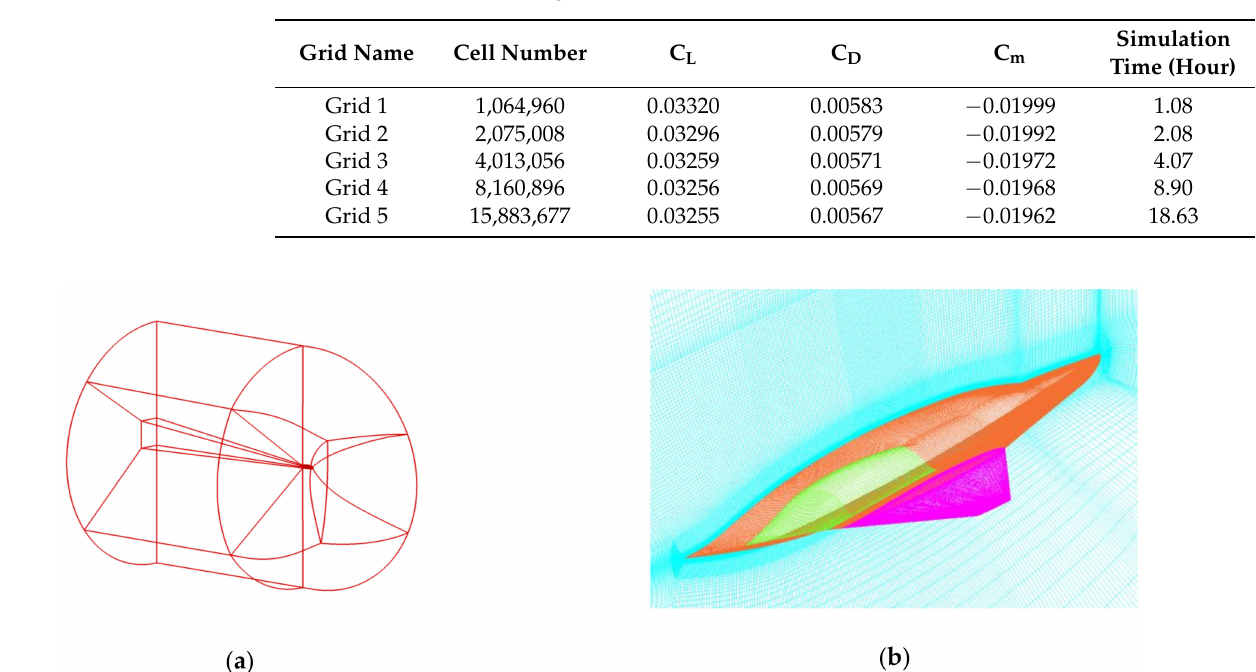
Table 4. Results of different grids.